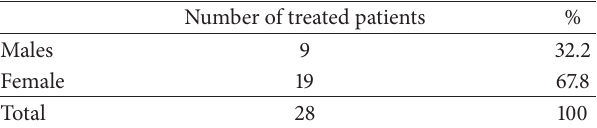
Table 1: Number of the patient veneers restorations.